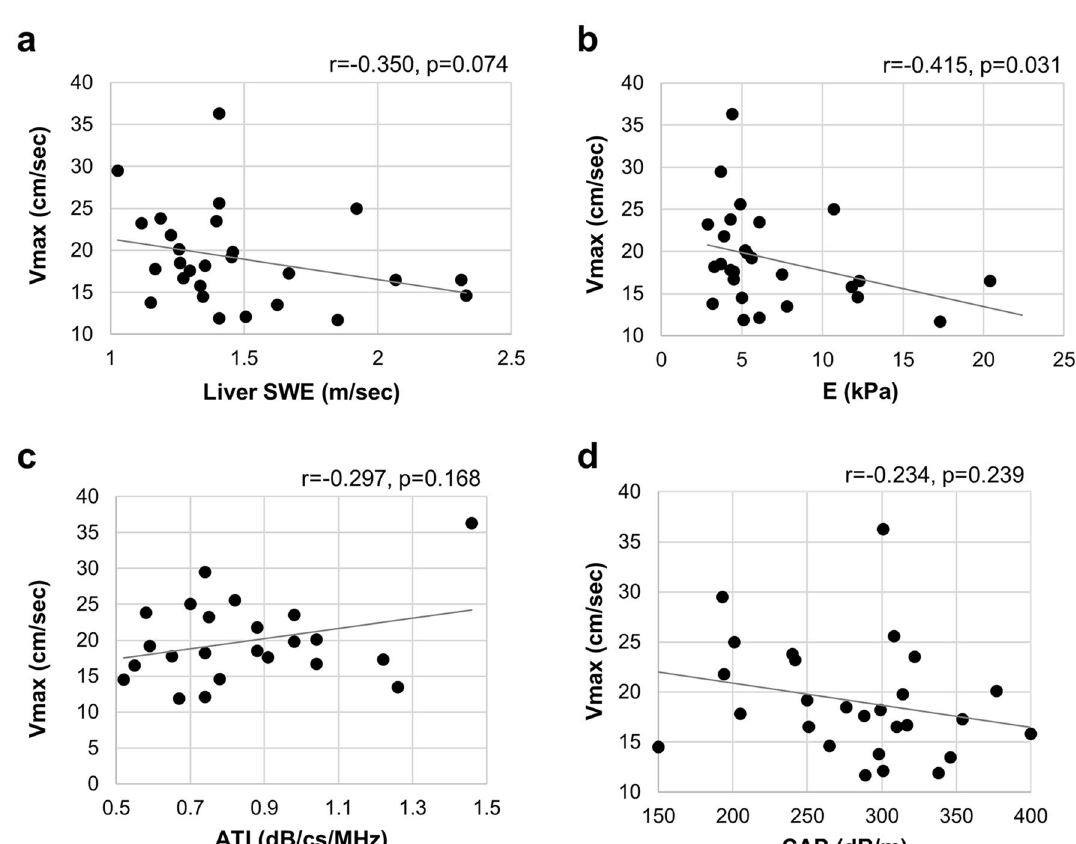
Figure 4. Correlation between the change in V max of right portal vein and ( a ) liver stiffness by 2D-SWE, ( b ) liver stiffness by TE with Fibroscan, ( c ) liver steatosis by ATI, and ( d ) liver steatosis by CAP with